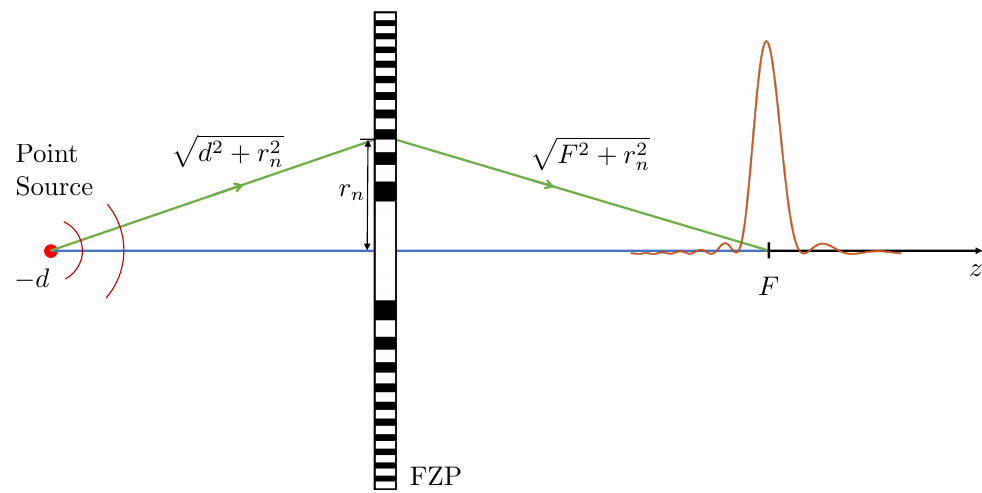
Figure 1. Schematic of FZP focusing with source point